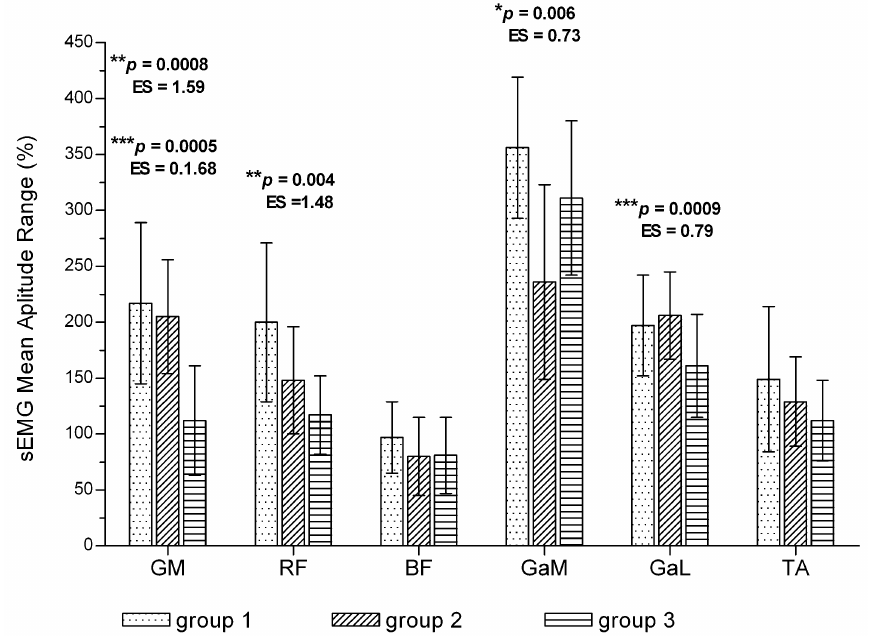
Figure 4. Differences in mean amplitude range of the sEMG signal among patients with different walking time. p *— p value between study groups 1 and 2; p **— p value between study groups 1 and 3; p ***— p value between study groups 2 and 3. ES—effect size (Cohen d). Values are expressed as mean ± SD